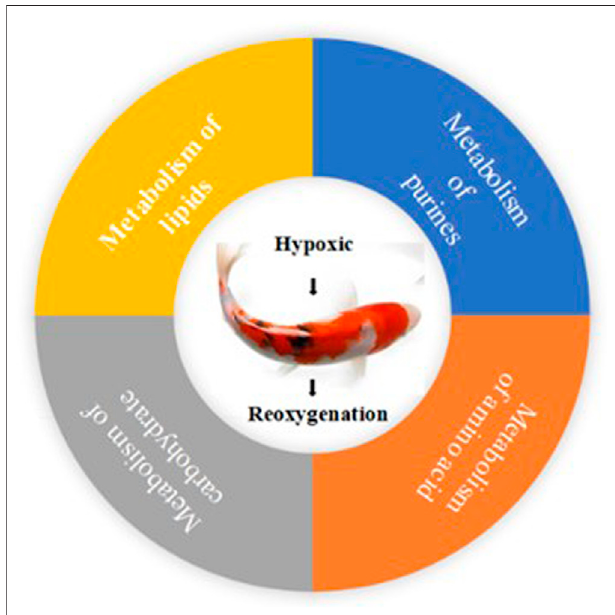
FIGURE 6 | The main metabolites and their related KEGG